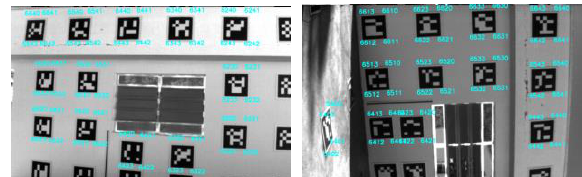
Figure 2. Hyperspectral images with Aruco targets identified.